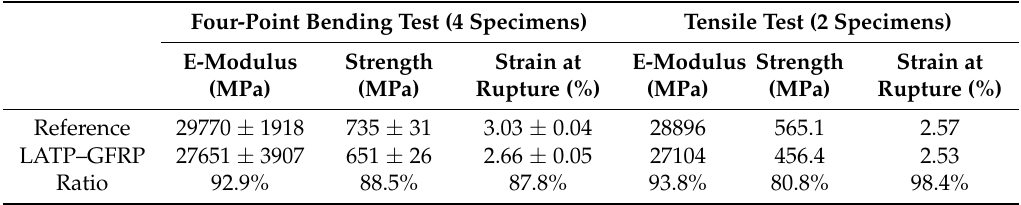
Table 1. Summary of the experimentally characterized mechanical properties of LATP–GFRP.